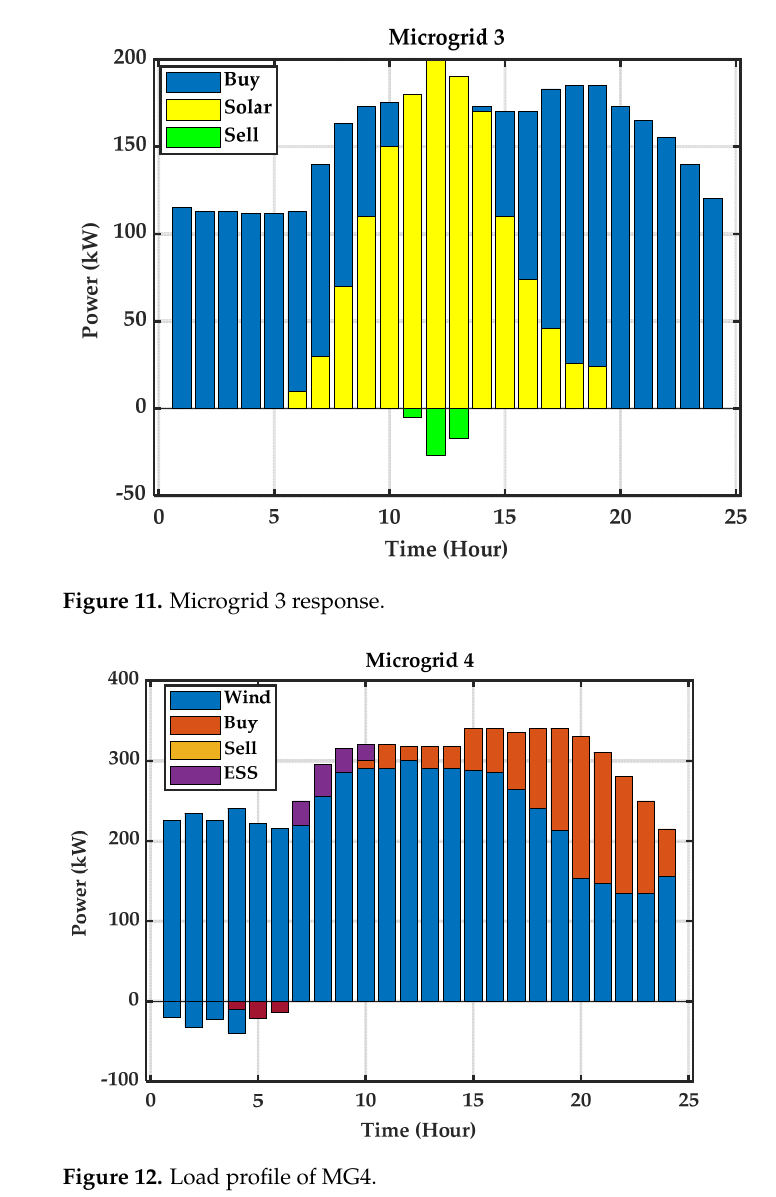
Figure 13. Load profile of MG5.